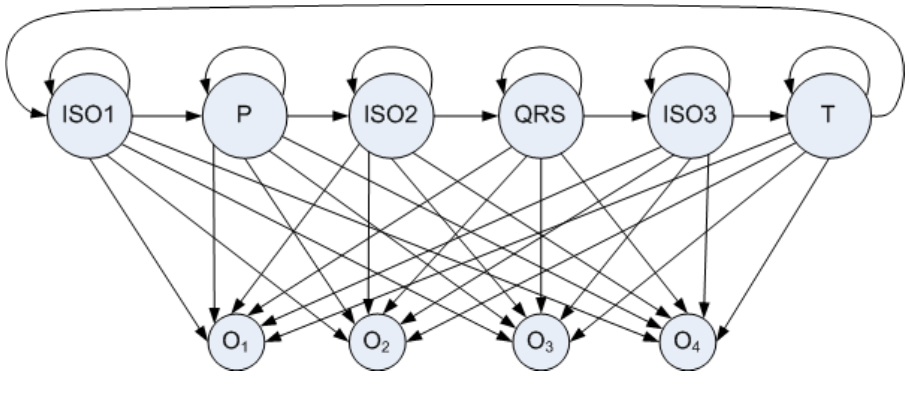
Figure 14. The revised Layer 1 HMM. A connection is added between ISO1 and ISO2.